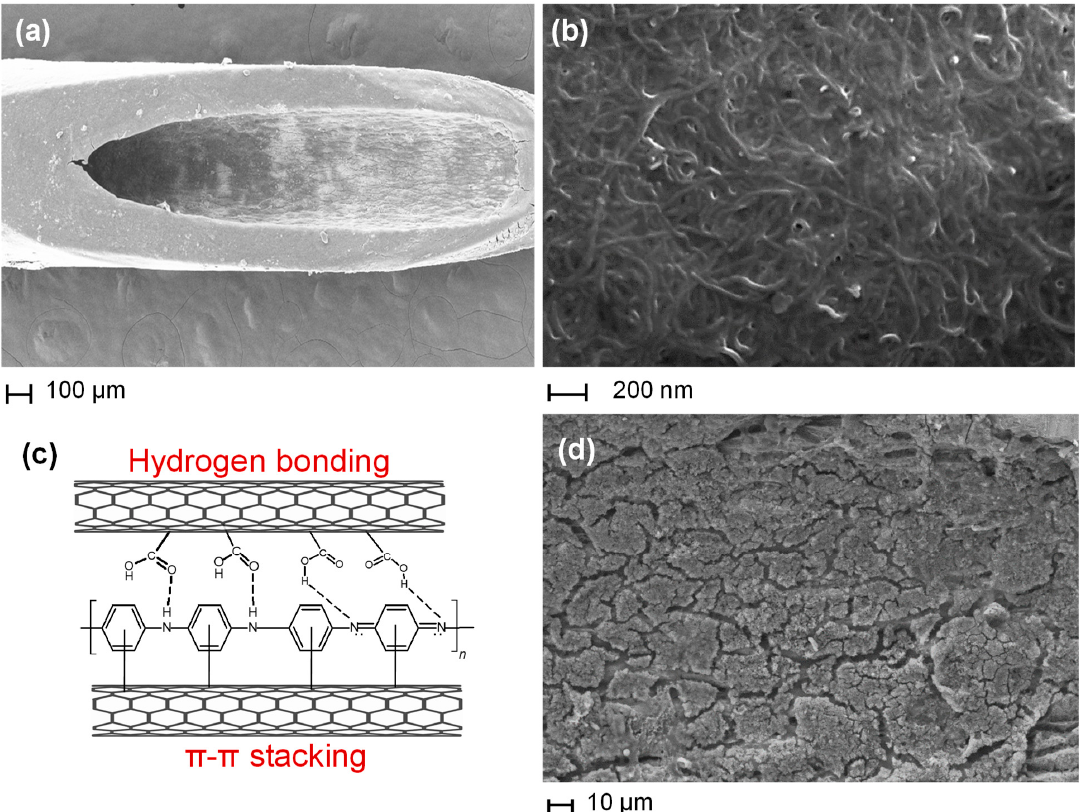
Figure 2. SEM images of the ( a ) CNT/CNC microneedle; and ( b ) enlarged view of open tips of the CNT/CNC microneedle and ( c ) Interaction of PANI and carboxylic functionalized CNT ( d ) SEM image of MN redox sensor.